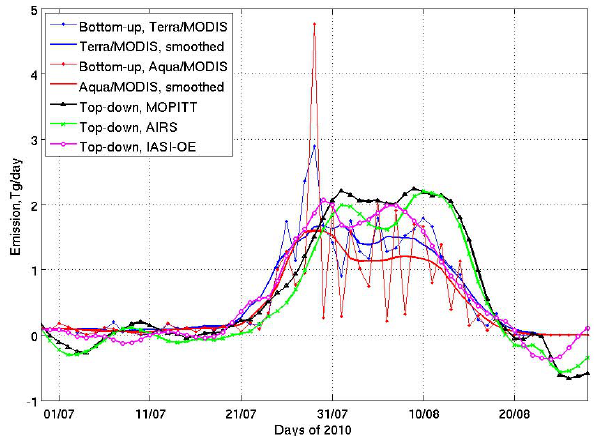
Fig. 15. A comparison of top-down and bottom-up CO emission estimates. Daily emission rates are calculated using inventory tech- nique by Fokeeva et al. (2011) with burned areas from two MODIS instruments; for a better comparison they were smoothed by